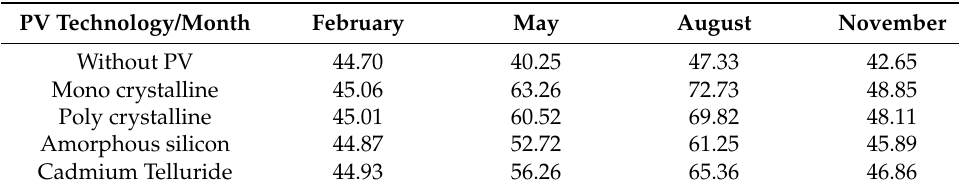
Table 7. PLO’s profit (€) by using different PV technologies.